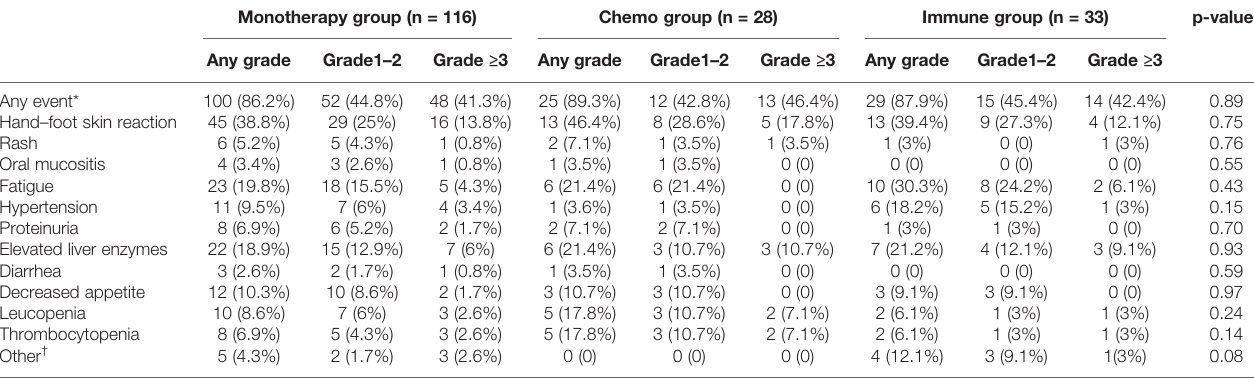
FIGURE 3 | Kaplan – Meier survival curves. (A, B) Kaplan – Meier survival curves of different starting doses on PFS and OS [ (A) PFS of patients with different start doses, p < 0.001; (B) OS of patients with different starting doses; p = 0.005]; (C, D) Kaplan – Meier survival curves of different fi nal doses on PFS and OS [ (C) PFS of patients with different fi nal doses, p = 0.045; (D) OS of patients with different fi nal doses; p = 0.003]. TABLE 3 | Adverse events of regorafenib